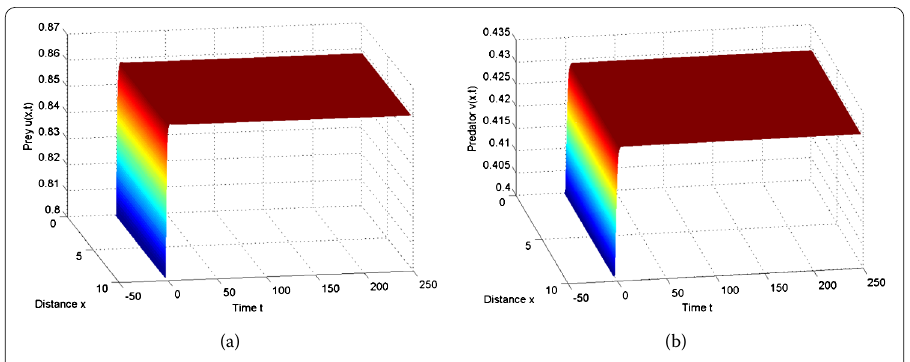
Figure 2 Numerical simulations of system (1.2) for a = 1, β = 2, d 1 = 1, d 2 = 10, b = 1, δ = 1. The positive equilibrium E ∗ of (1.2) is globally asymptotically stable with the initial value (0.8,0.4).